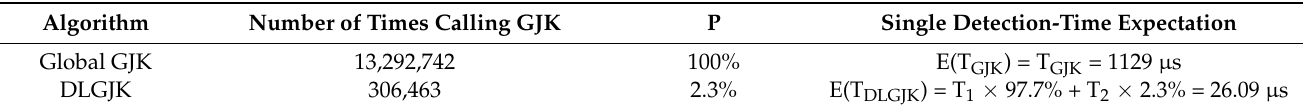
Table 6. RF-LF workspace self-collision detection time expectation of Global GJK and DLGJK.